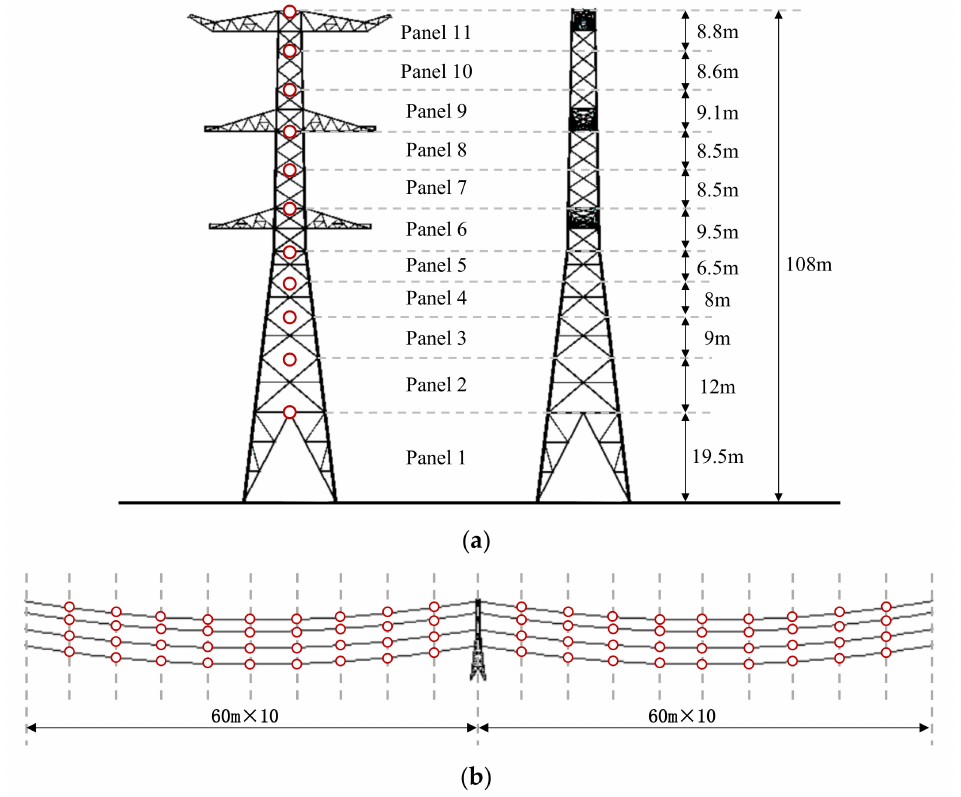
Figure 7. Diagram of load area division and wind load simulation points: ( a ) tower; ( b ) tower- line